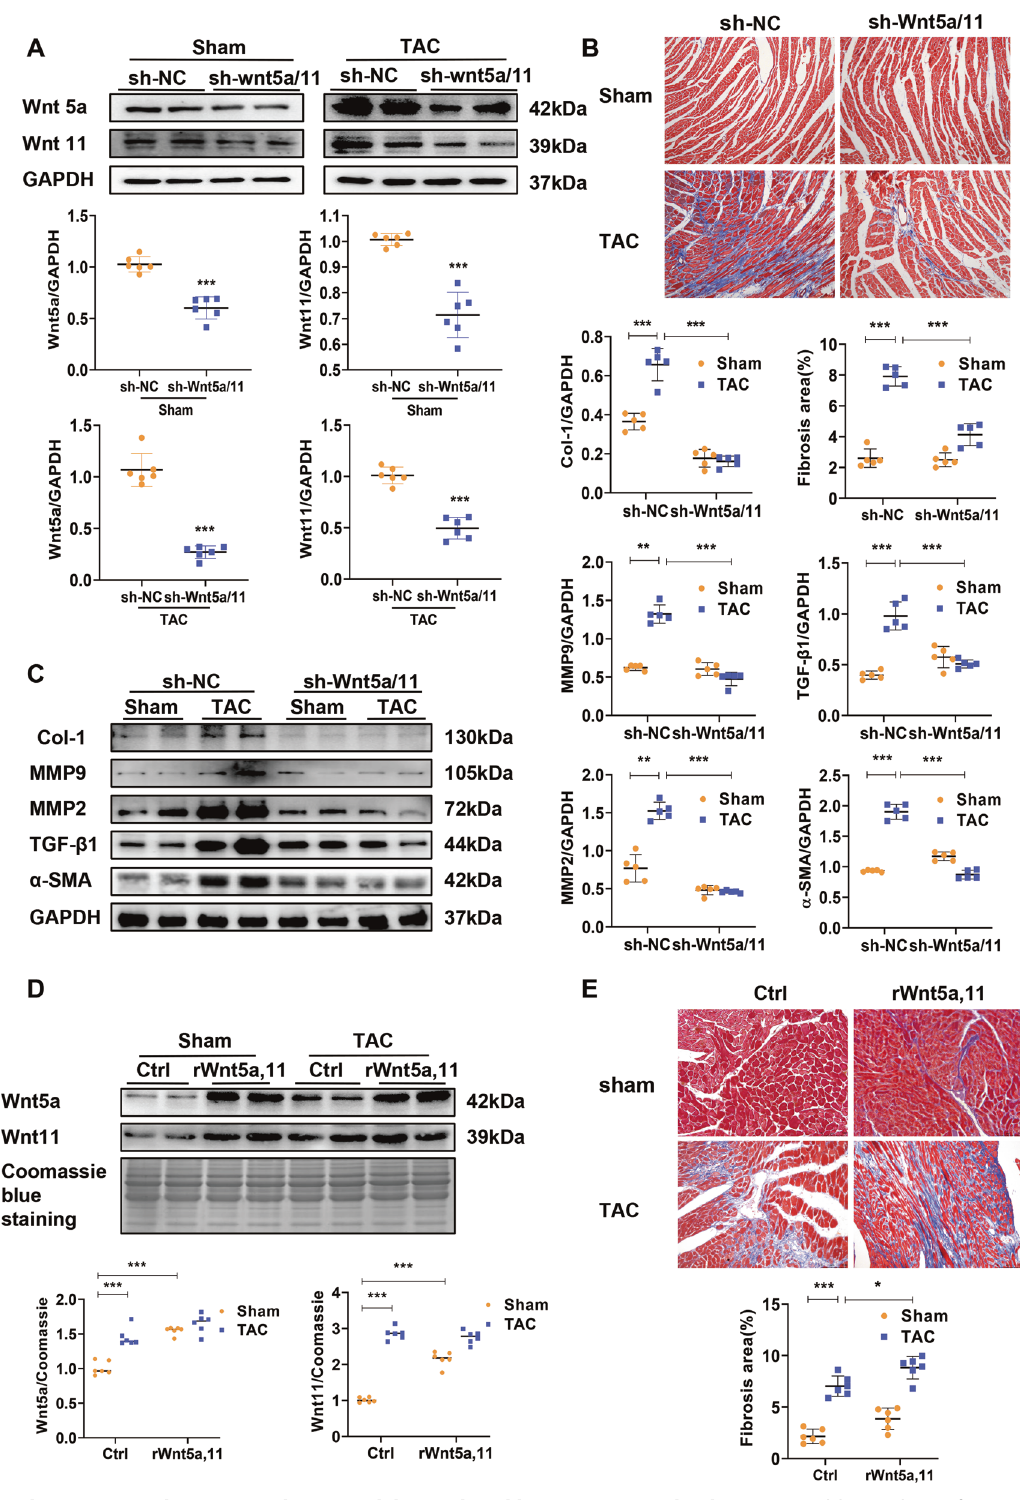
Fig. 3 Wnt5a and Wnt11 contributes to cardiac remodeling induced by pressure overload. A Western blot analysis of Wnt5a and Wnt11 in heart tissues ( n = 6/group). B Cardiac fi brosis was analyzed by Masson staining in heart tissues ( n = 5/group). C Western blot analysis of Col-1, MMP2, MMP9, and TGF- β 1 levels in heart tissues ( n = 5/group). Mice were injected with sh-Wnt5A /Wnt11-AAV9 (shWnt5a/11) or sh-Scramble- AAV9 (sh-NC) by tail vein, 2 weeks later, these mice were subjected to TAC or sham operation. After 4 weeks, further analysis was performed. D Western blot analysis of serum Wnt5a or Wnt11 level at 4 weeks after sham or TAC operation, and these mice were infused recombinant rat Wnt5a (rWnt5a) and Wnt11 (rWnt11), or vehicle (as control) by minipump for 2 weeks from the sham or TAC operation ( n = 6/group). E Cardiac fi brosis was analyzed by Masson staining in heart tissues ( n = 6/group). All data were shown as mean ± SEM; * P < 0.05, ** P < 0.01, *** P < 0.001.